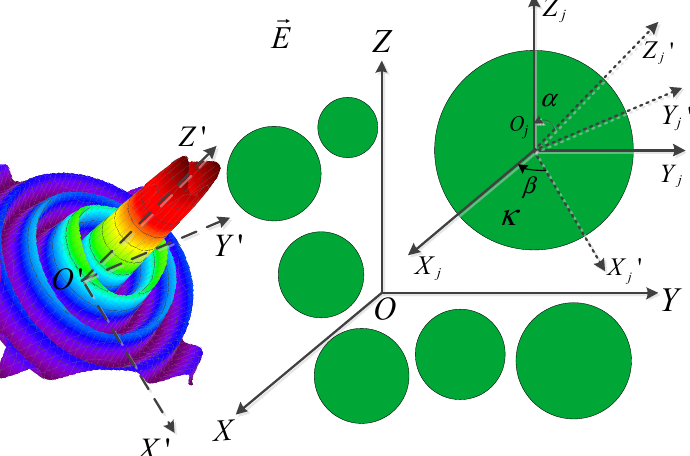
Figure 1. Illustration of multiple chiral spheres scattering induced by an arbitrarily polarized high- order Bessel bam (HOBB).